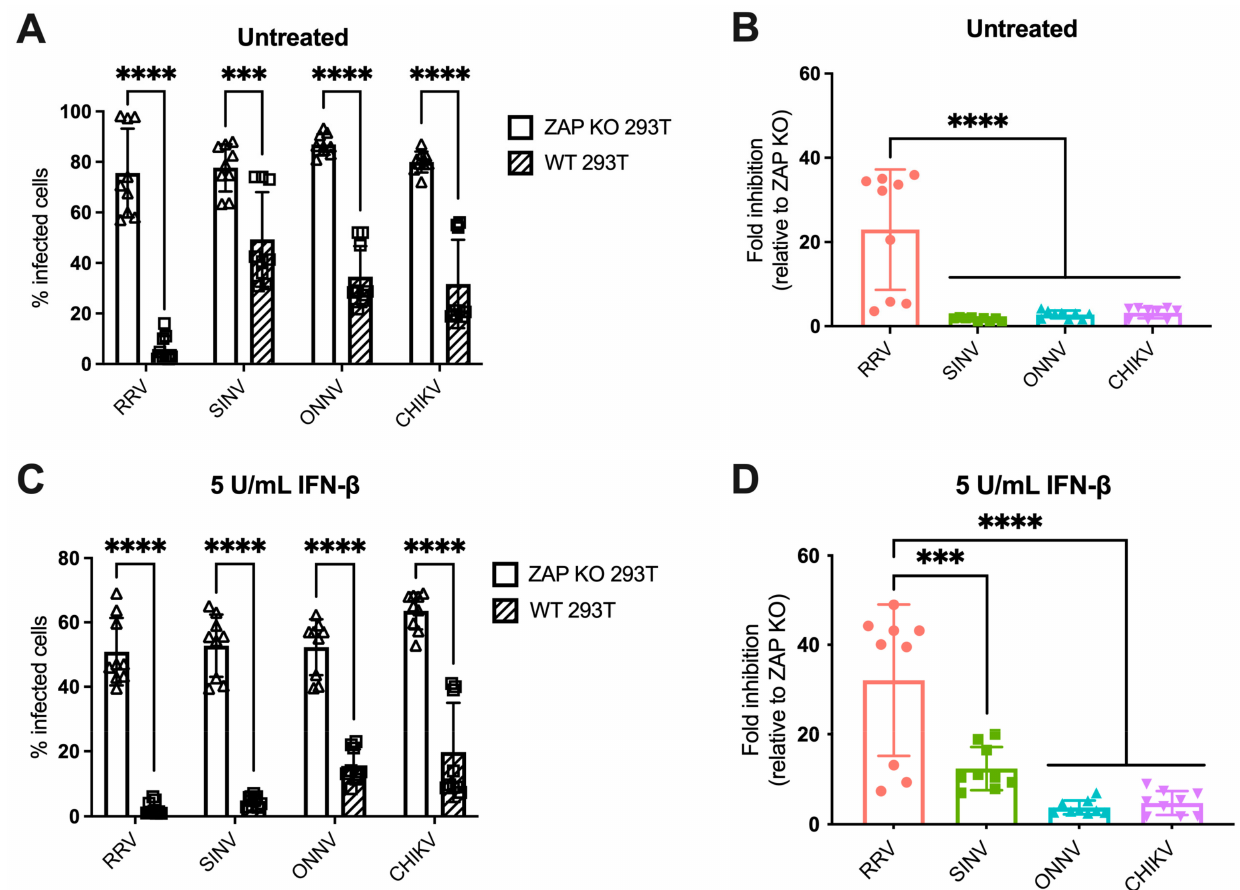
Figure 1. Alphavirus replication shows differential sensitivity to endogenous ZAP in 293T cells. ( A , C ) ZAP KO and WT 293T cells untreated ( A ) or treated with 5 U/mL IFN- β for 24 h ( C ) were infected with GFP-expressing RRV, SINV, ONNV, or CHIKV vaccine strain 181/clone 25 (MOI = 1 PFU/cell). Cells were harvested and fixed at 24 h post-infection (h.p.i.), and their percent- age of infection was determined by flow cytometry. Data are combined from three independent experiments performed with biological replicates in triplicate wells. Error bars represent the standard deviations (SD). Asterisks indicate statistically significant differences (unpaired T test with Holm– Š í d á k’s multiple comparisons test: ***, p < 0.001; ****, p < 0.0001). ( B , D ) Fold inhibition of alphavirus replication by ZAP. Data from panels A ( B ) or C ( D ) are represented. Fold inhibition relative to ZAP KO was calculated by dividing the percentage of infection of each virus in ZAP KO 293T cells by the percentage of infection in WT 293T cells. Error bars represent the standard deviations (SD). Asterisks indicate statistically significant differences (one-way ANOVA and Tukey’s multiple comparisons test: ***, p < 0.001; ****, p <